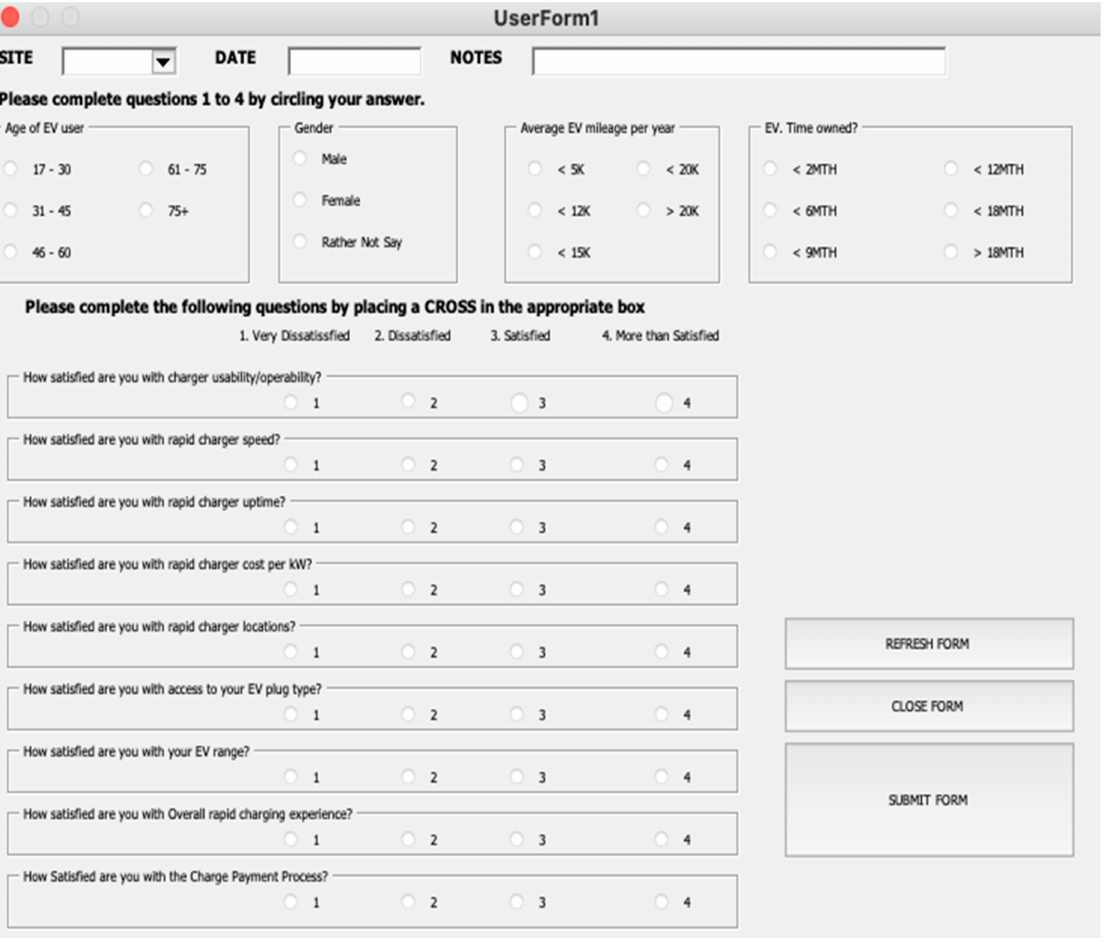
Figure 18. Survey data input template used in both tablet and paper